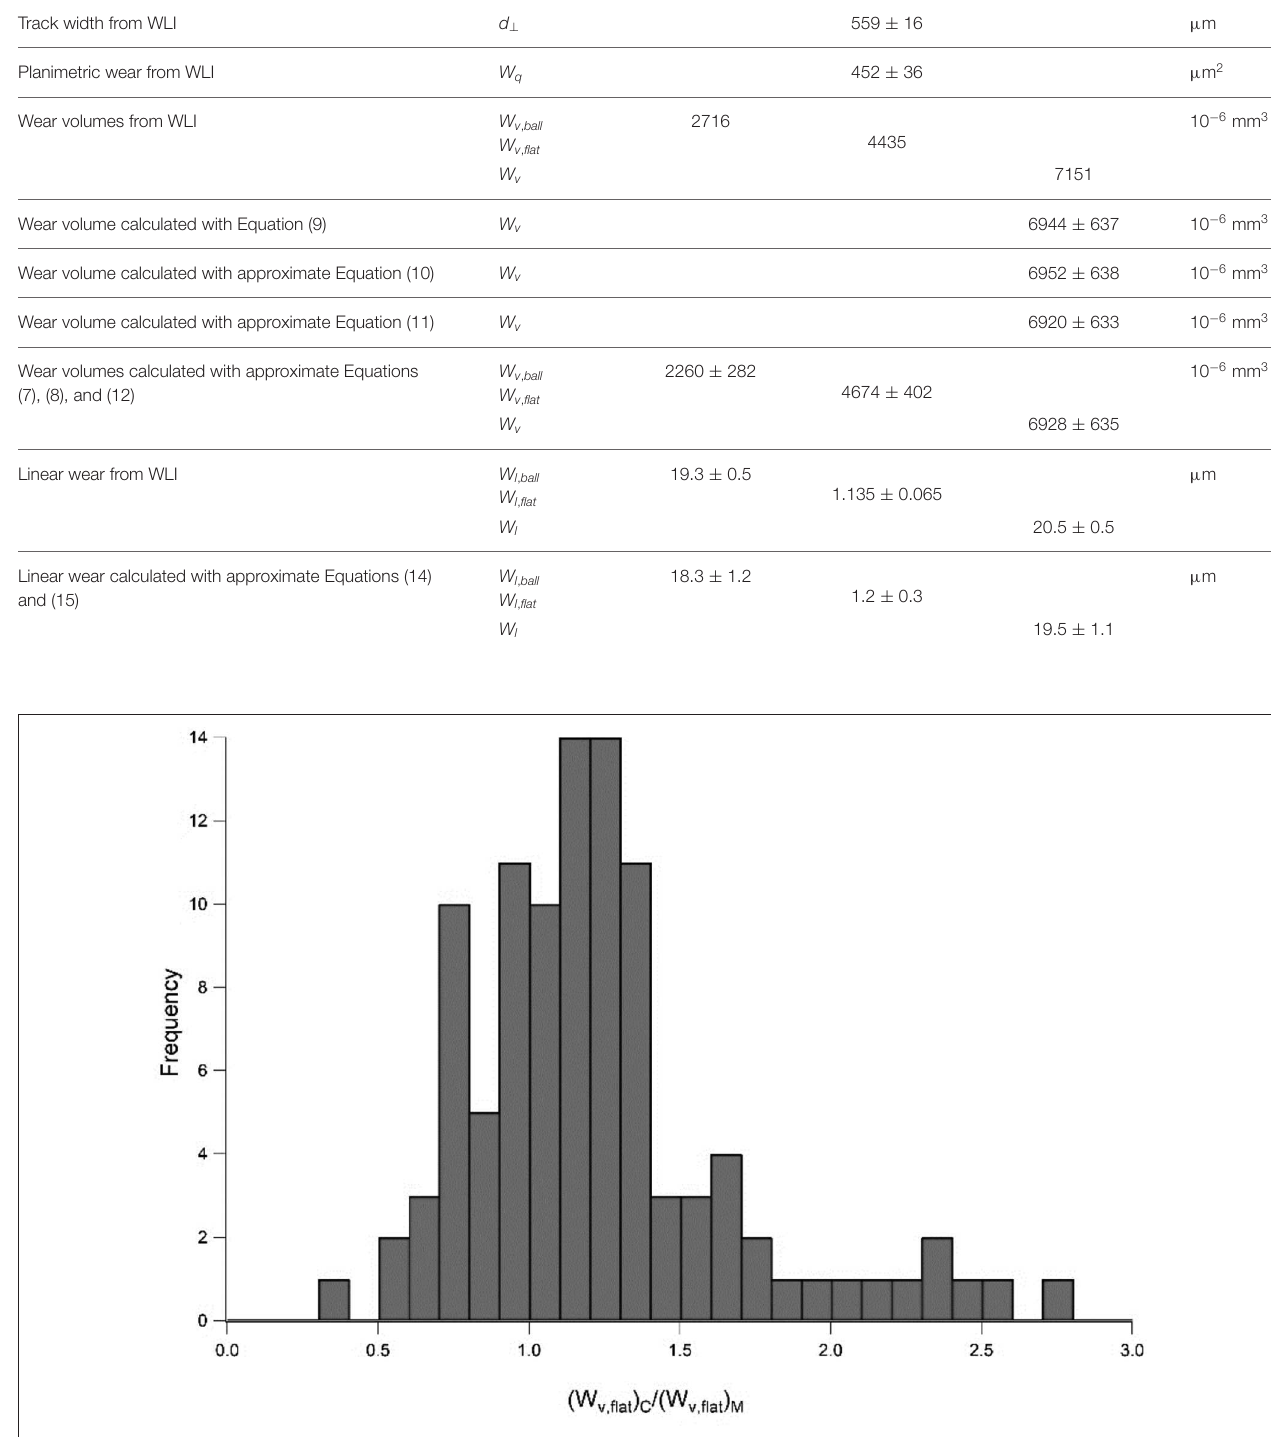
Frontiers in Mechanical Engineering |